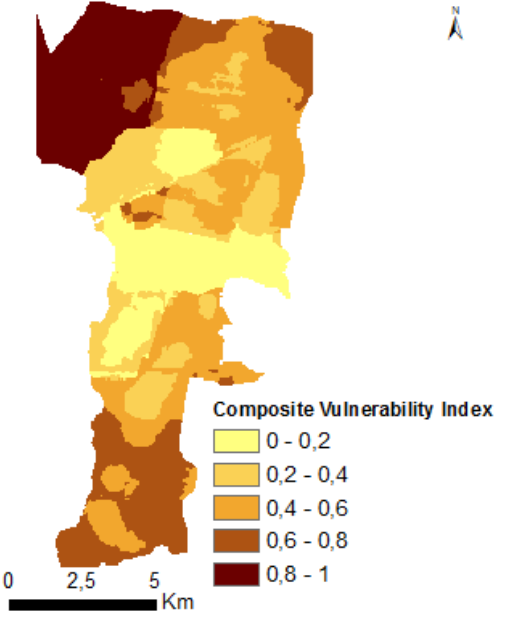
Figure 15. Composite Vulnerability